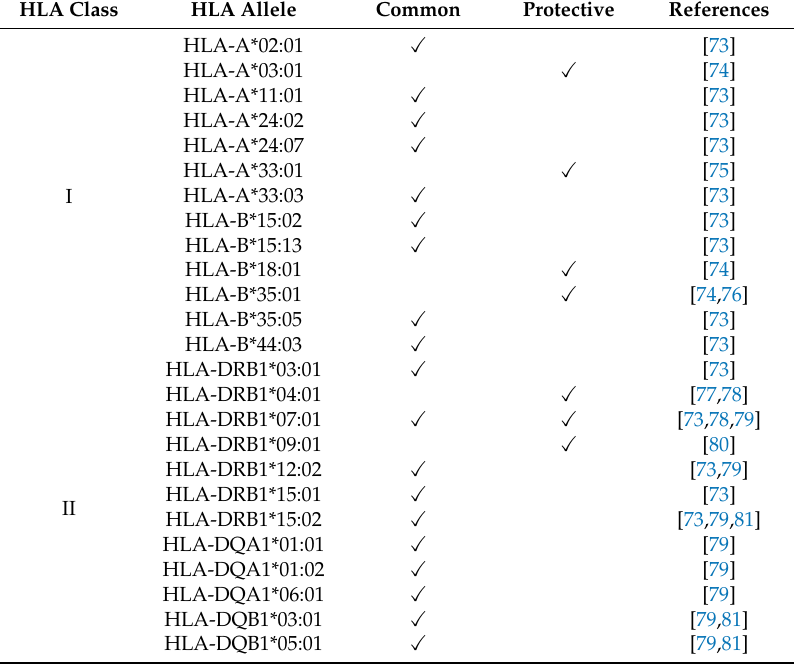
Table 1. Human leukocyte antigen (HLA) alleles for T-cell epitope mapping the common and protective to dengue virus (DENV). HLA Class HLA Allele Common